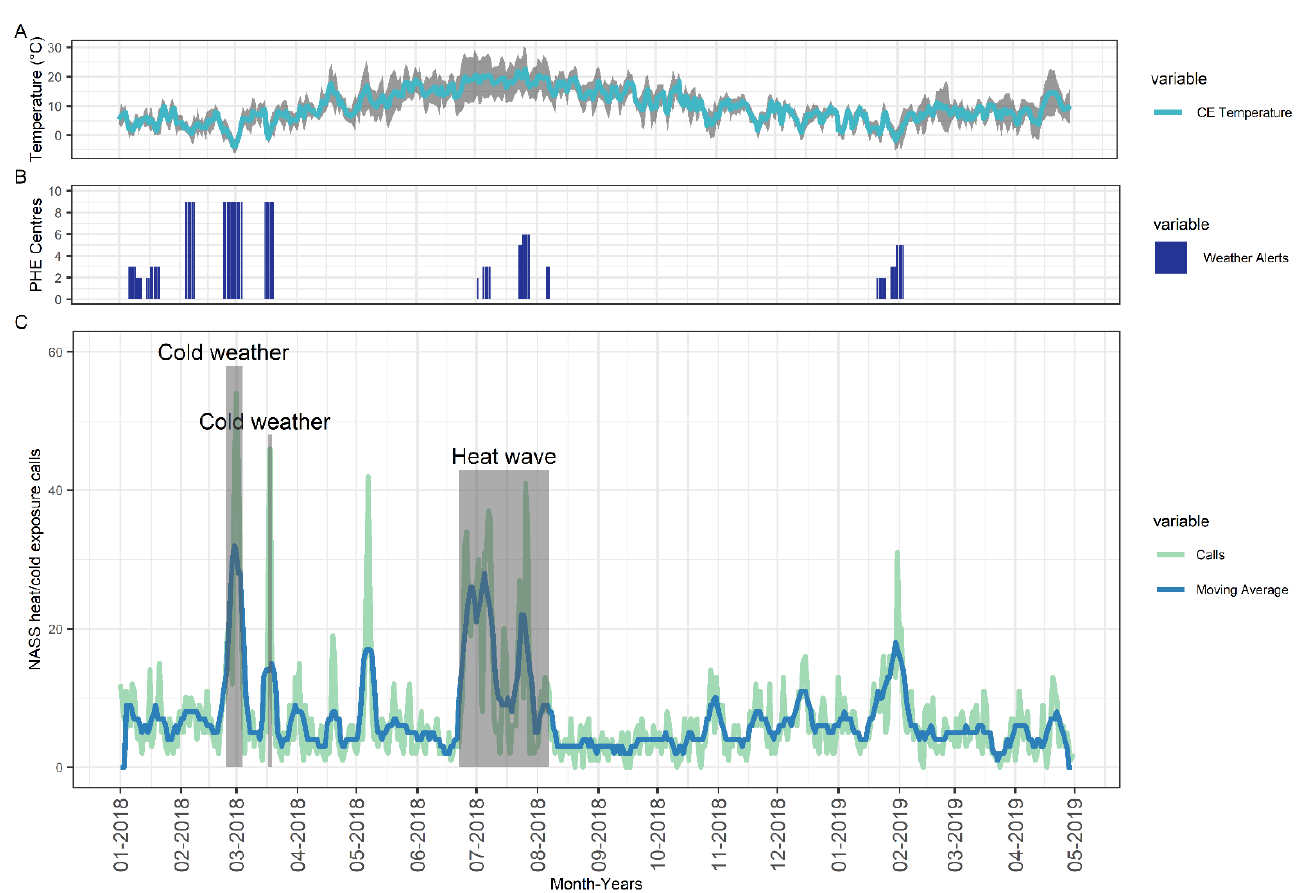
Figure 1. ( a ) mean (blue line), min and max (grey area) central England (CE) temperature (top panel) over time, ( b ) PHE Heat Health and Cold Weather Alerts (middle panel), and ( c ) Number of Heat/cold exposure CPC calls (bottom panel) with extreme weather events identified a priori marked on graph in grey boxes.